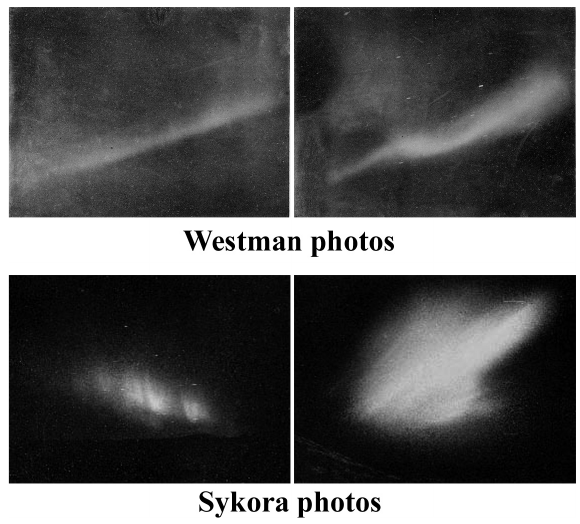
Fig. 6. Examples of photographs of aurora taken by Sykora and